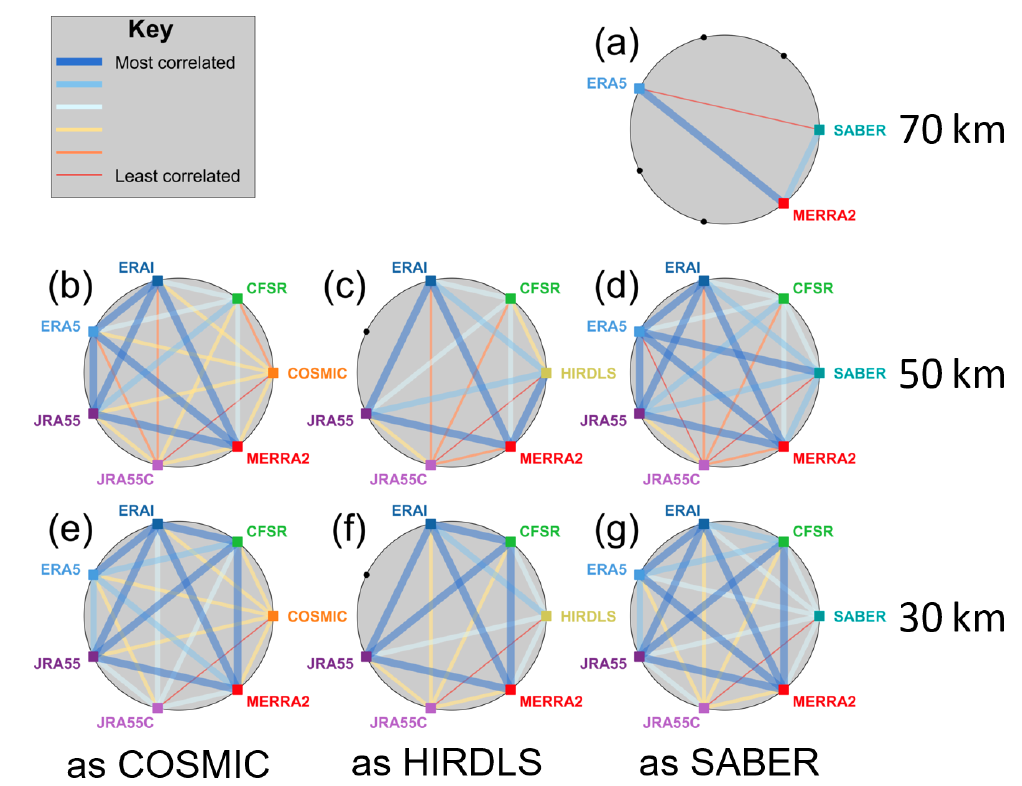
Figure 15. Pairwise correlation between each dataset at three height levels. Black dots and coloured squares around each circle indicate nodes representing each model or observational dataset, with coloured squares indicating comparisons performed and black dots indicating unavailable comparisons due to spatial and temporal coverage constrains. Coloured lines joining nodes indicate pairwise correlations between the data sources associated with those nodes, described by the key at the top